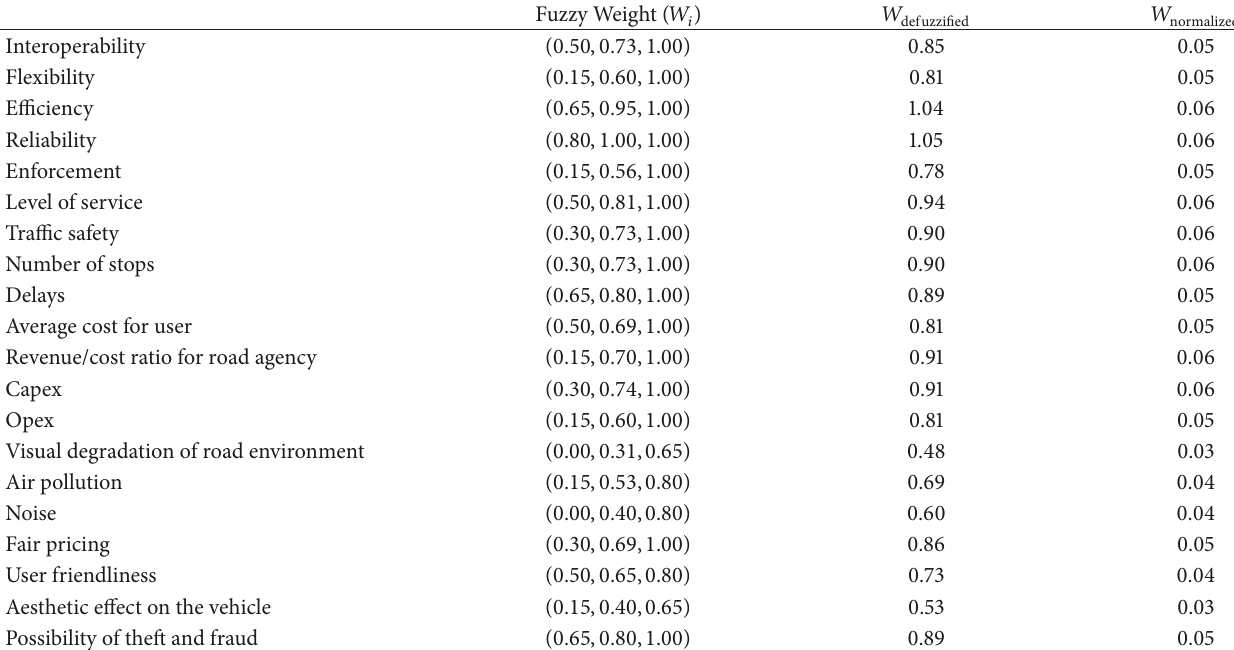
Table 6: The values of criteria